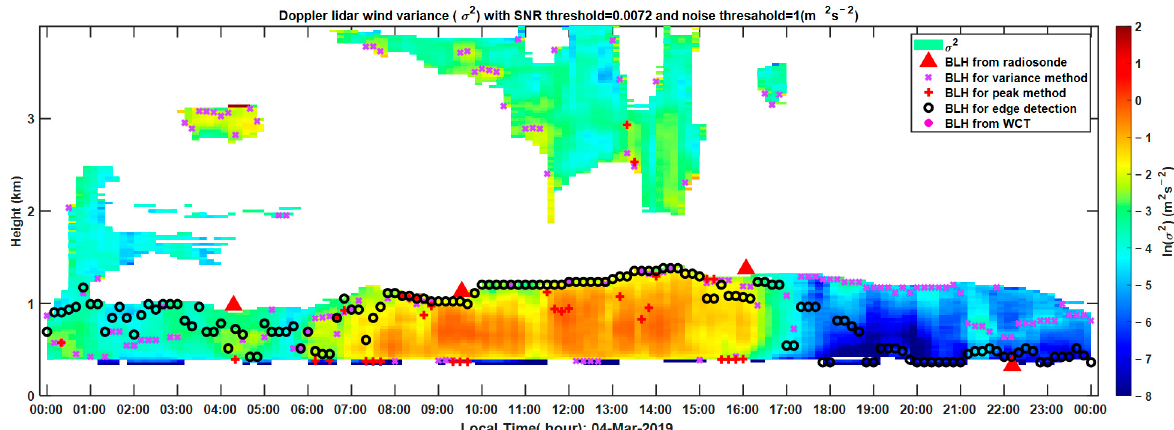
Figure 4. BLHs on 4 March 2019 obtained using the variance, peak, and ED methods compared with the RS measurements.